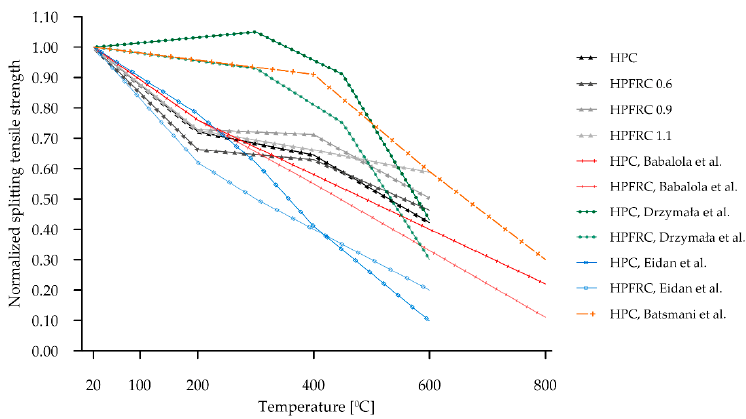
Figure 19. Comparison of tensile strength with literature data [17,35,39,65].